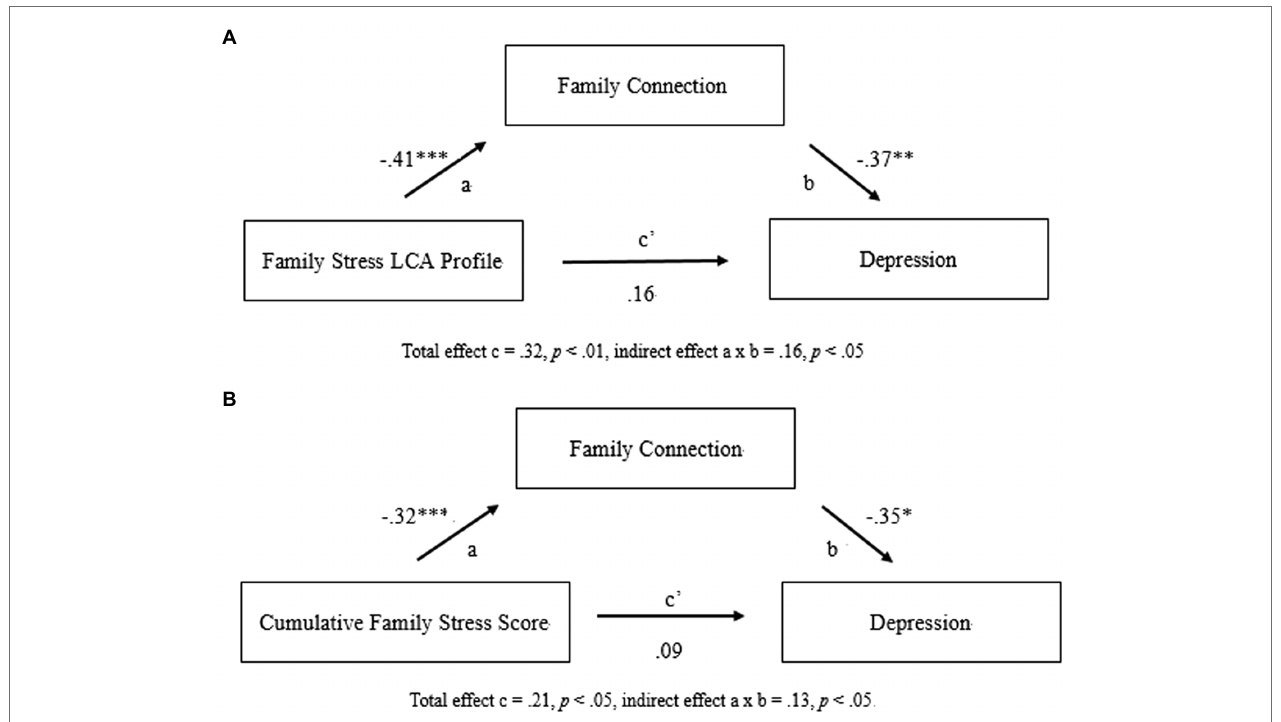
FIGURE 2 | Abbreviated models showing the indirect relationship between family stress, family connection, and depression variables in the Tayal sample (Panel A shows family stress LCA profile, and Panel B shows cumulative family stress score). Regression coefficients are reported using standardized value. The regression coefficients here might be slightly different from the values reported in Tables 6 and 7 , because the values here were obtained using bootstrap tests. * p < 0.01, ** p < 0.01, and *** p <